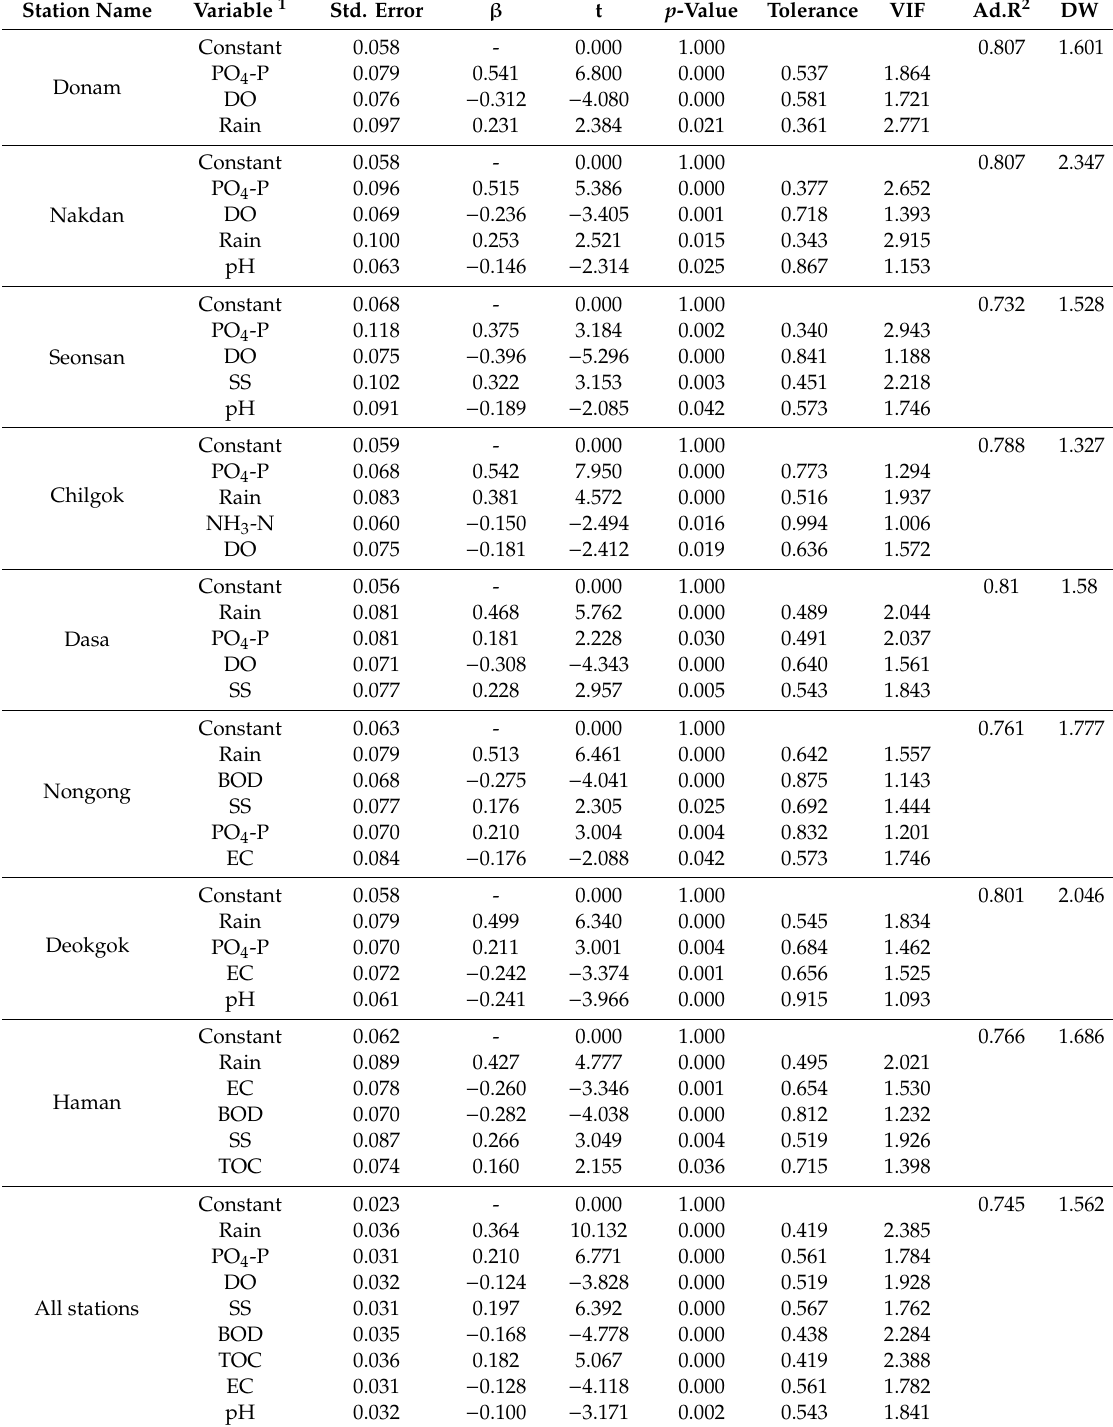
Table A2. Multiple regression results between fecal coliforms and water quality factors at each weir